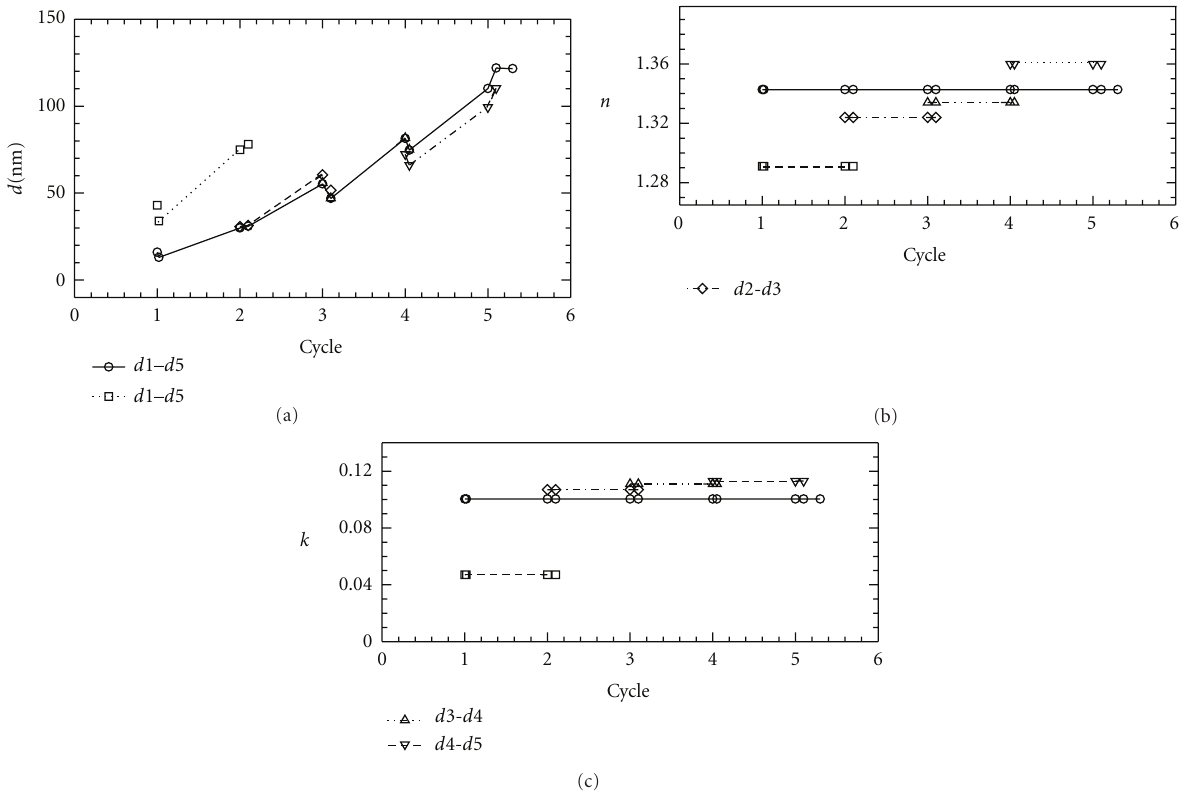
Figure 7: Calculated thickness, d , and optical indices, n , k , for the Ppy layers already described in Figure 3(a), Ea = 1.2V, τ = 20s. SDS solution, λ = 546 nm. The di ff erent values n and k correspond to the resulting fitted values for di ff erent set of thicknesses. to the polarons occur. Several π - π ∗ transitions and polarons band are reported for di ff erent Ppy/doped layers [37,